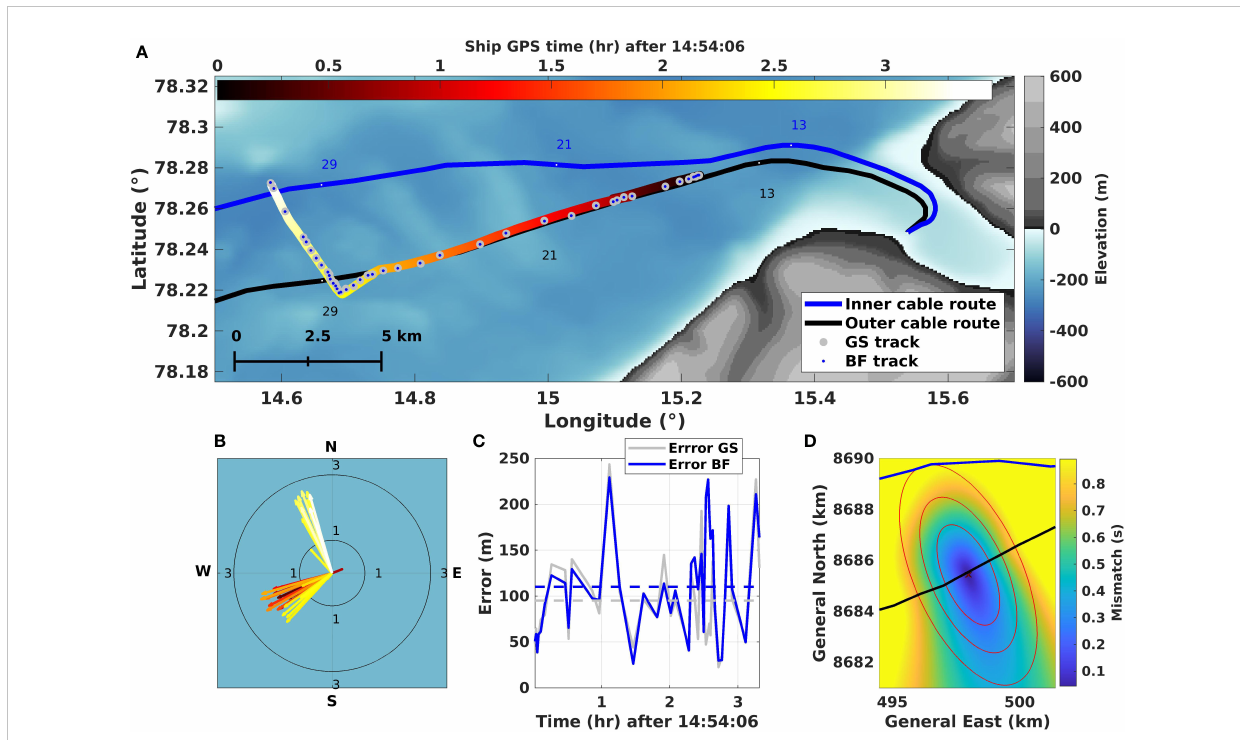
FIGURE 2 Tracking the air gun with known shot locations. (A) Overview of the fi rst 35 km section of cables, showing ship track, color-coded from dark to light (by origin time of shots) overlaid with the estimates from the grid search (GS; big gray circles) and the Bayesian fi lter (BF; small blue circles). (B) The associated velocities of the ship are estimated by the BF with the same color coding as (A) . (C) The error between the estimated location and the known position of the ship at the shot origin time. (D) RMS mismatch from GS overlaid by the error ellipse (1x, 2x, 3x standard deviation) from the BF based on a representative shot with an error (100 m) close to the mean error of all